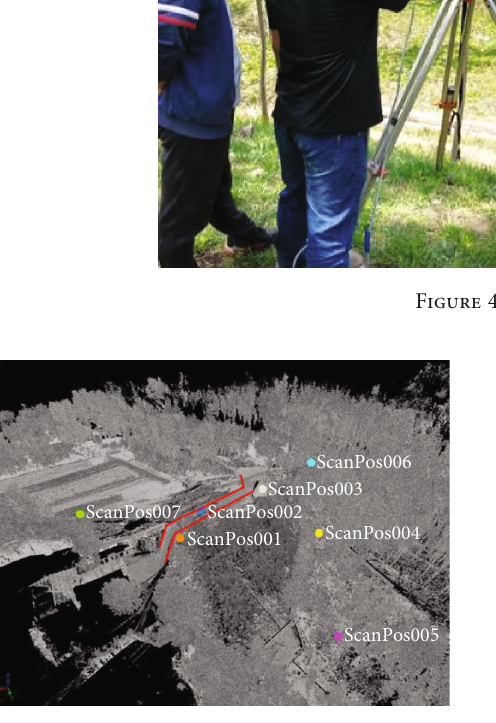
Figure 5: The distribution of